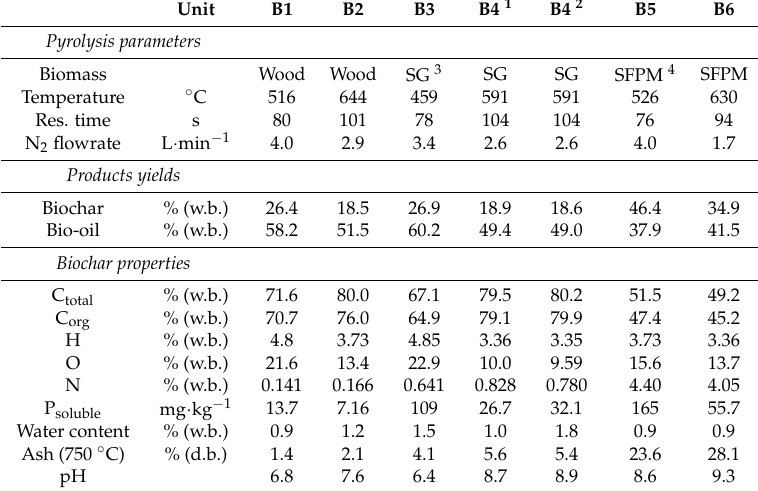
Table 4. Products yields and physicochemical properties of biochars produced with optimal pyrolysis operating